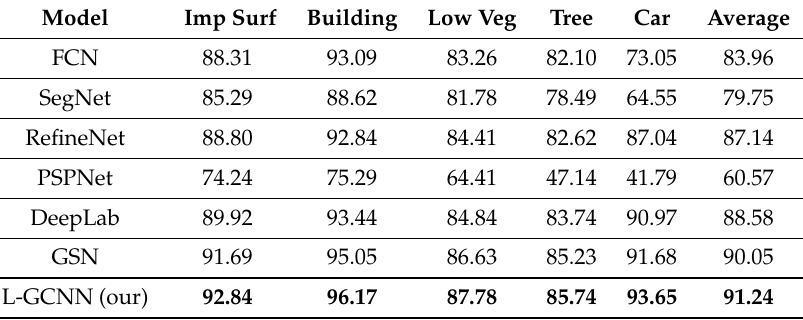
Table 2. F 1 scores (%) obtained on Potsdam dataset. “imp surf”: “impervious surfaces”; “low veg”: “low vegetation”.